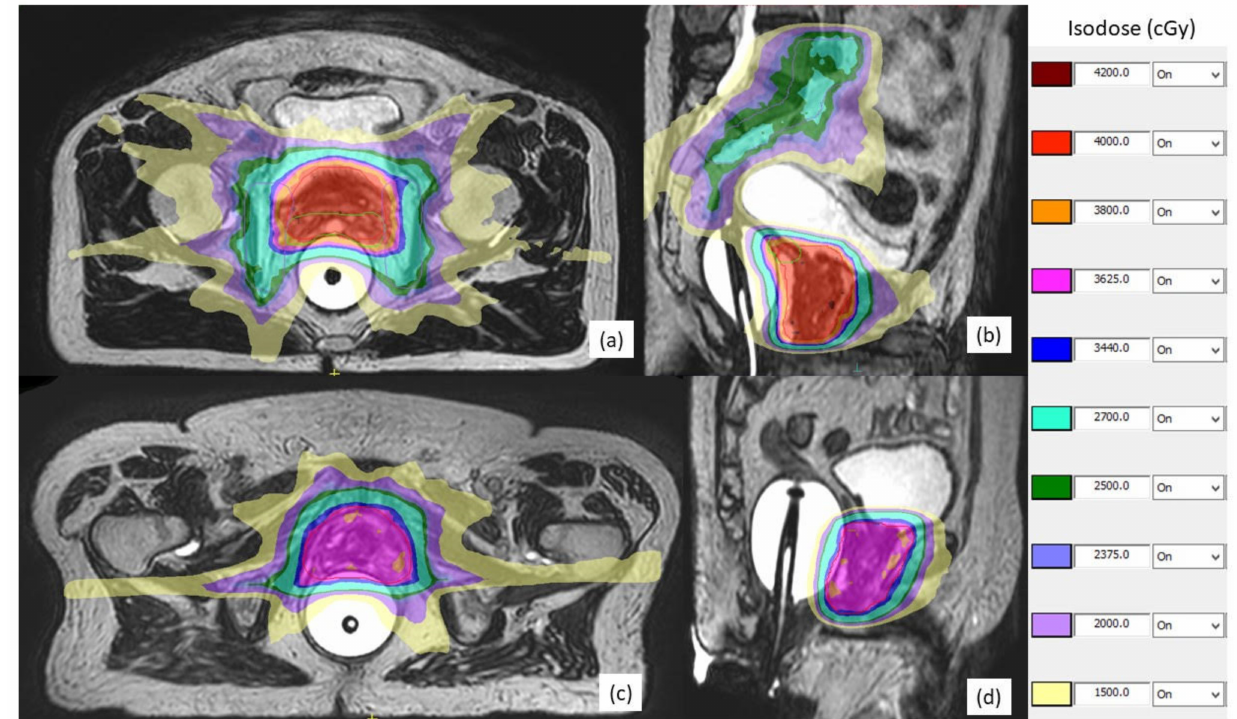
Figure 3. Examples of magnetic resonance-guided stereotactic body radiotherapy plan dose prescription of 40 Gy on a high-risk localized prostate cancer patient ( a , b ), and of 36.25 Gy on a low-risk ( c , d ) patient. A 25 Gy dose was concurrently prescribed to the pelvic nodal volume for the high-risk patient. Colors are used to illustrate different isodose